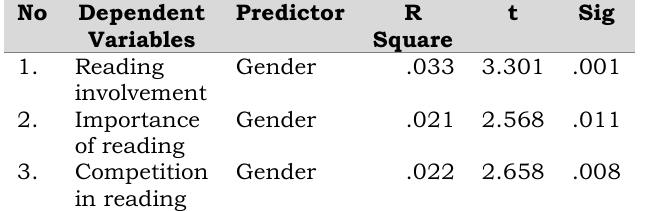
Table 4. Summary of Regression Analysis for Reading Motivation Dimensions No Dependent Predictor R Variables